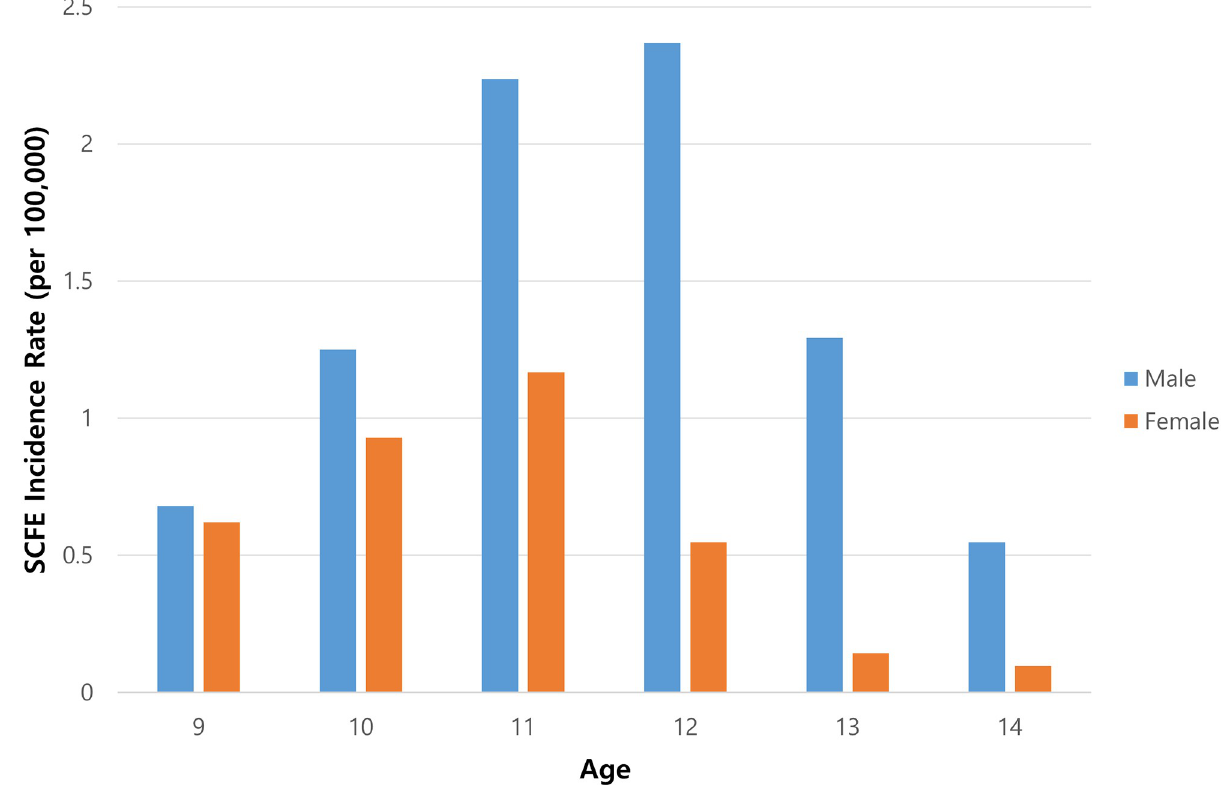
Fig 1. Incidence rate of slipped capital femoral epiphysis by age group.